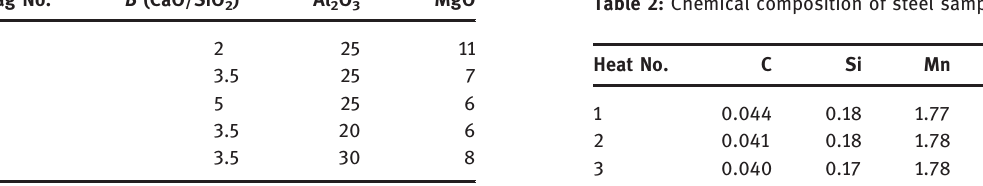
sulfur content for the three heats. Table 2: Chemical composition of steel samples, mass%.